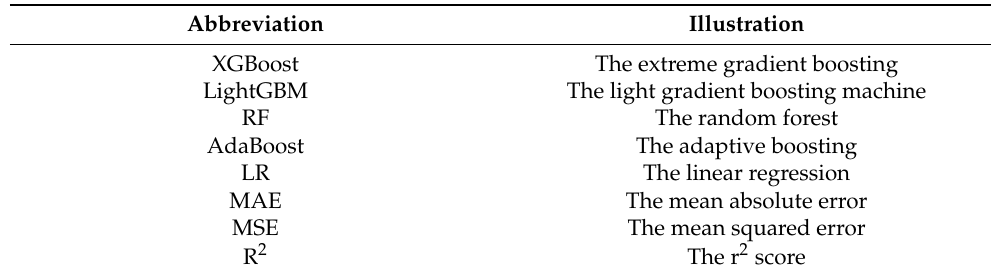
Table 3. The nomenclature of the paper.